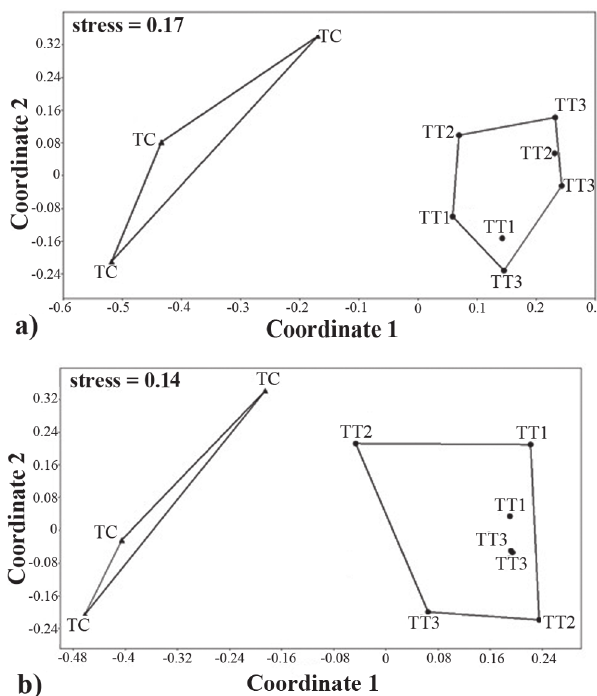
Fig. 3. Projections of the Non-Metric Multidimensional Scaling (NMDS) and the smallest convex hulls that contain all data of the structurally complex streams (TT1, TT2 and TT3) and simplified stream (TC) according to a ) taxonomic structure and b ) trophic